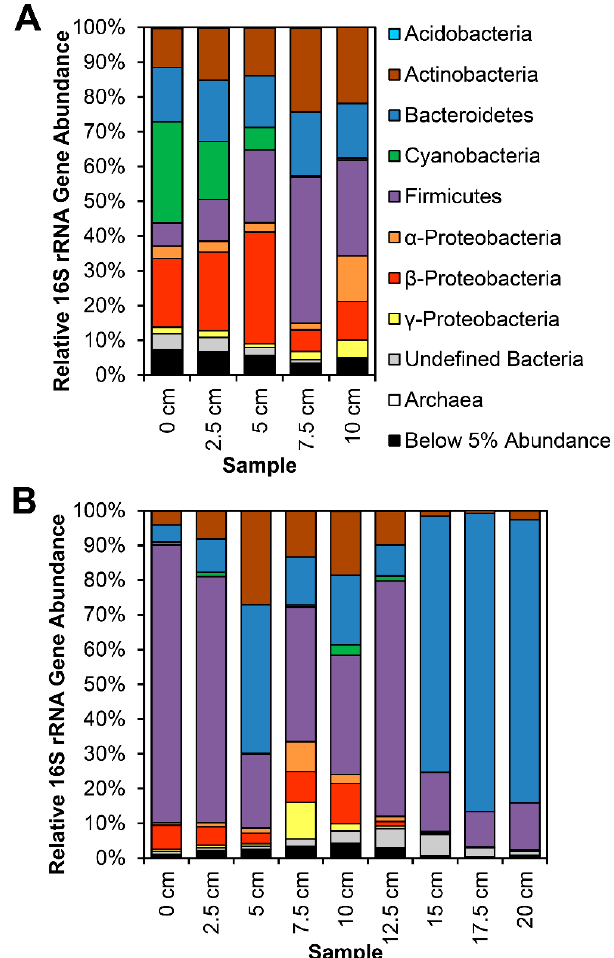
Figure 4. Phylum- and Proteobacterial class-level 16S rRNA gene relative abundances in two vertical transects collected at Site 4: ( A ) 3 cm diameter core collected in April 2014; ( B ) 7.5 cm diameter core collected in March 2015. Depth indicates the top side of each core segment, starting at the top of the calcium carbonate flocculent. Water column is not included, but averaged 5-10 cm above sediment.